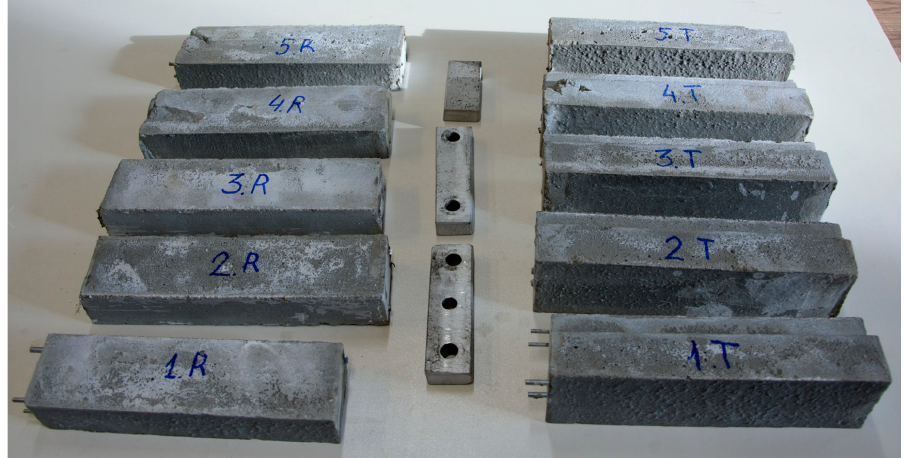
Figure 9. Test samples before the experiment. Whitish traces of Teflon grease are visible. Reinforce- ment protrusions are made to prevent errors: rods of larger diameter are laid at the lower faces. Support and cargo steel plates are located in the center of the photo between the beams.